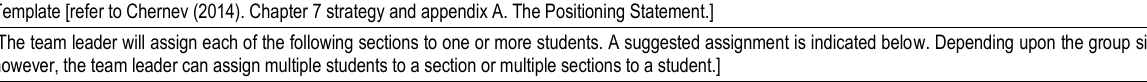
Table 4. Marketing strategy (target market and value